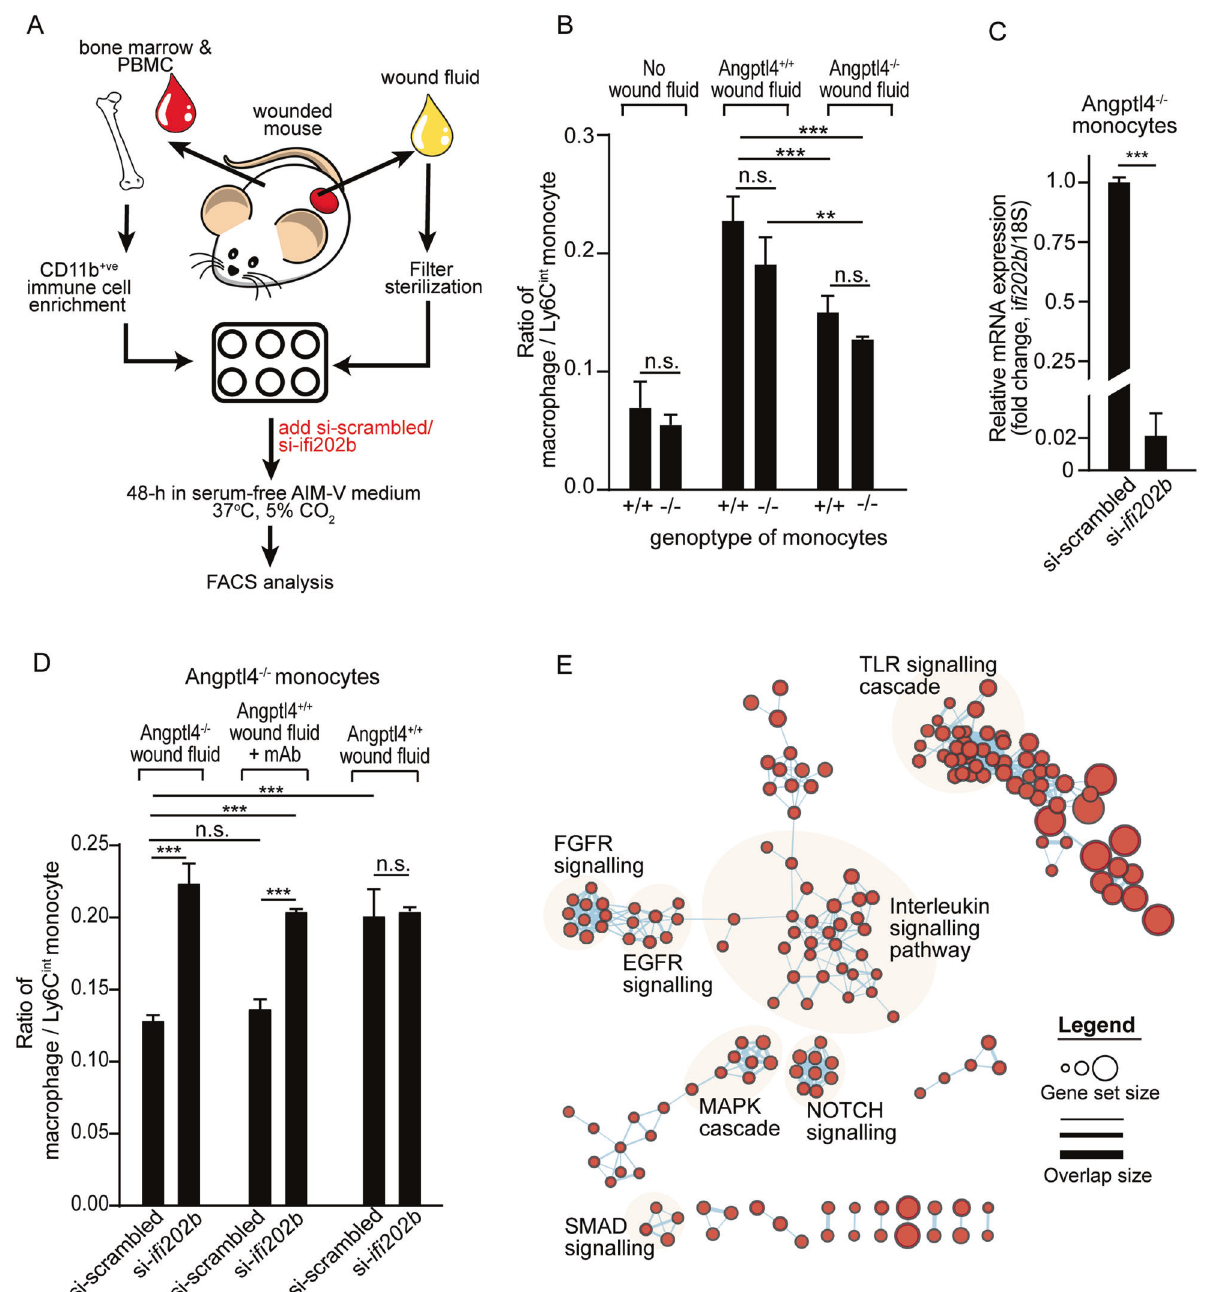
Fig. 3 I fi 202b silencing promotes monocyte differentiation to macrophages. A Schematic illustration of in vitro monocyte culture supplemented with wound exudate to mimic the in vivo wound microenvironment. PBMC, peripheral blood mononuclear cells. B Ratio of macrophage-to-Ly6C int monocytes in Angptl4 + / + and Angptl4 − / − monocytes treated with the indicated wound fl uids. Values represent mean ± SD. C Relative mRNA expression i fi 202b in Angptl4 − / − monocytes challenged with Angptl4 − / − wound fl uid and treated with si-i fi 202b. Gene expression was normalized to 18 S rRNA. D Ratio of macrophage-to-Ly6C int monocytes in Angptl4 − / − monocytes cultured in the indicated wound fl uids. Endogenous expression of i fi 202b was suppressed by si-i fi 202b. si-scrambled served as negative control. mAb denotes blocking anti-cAngptl4 monoclonal antibodies. E Functional GSEA of the interaction network associated with i fi 202b. Highly enriched